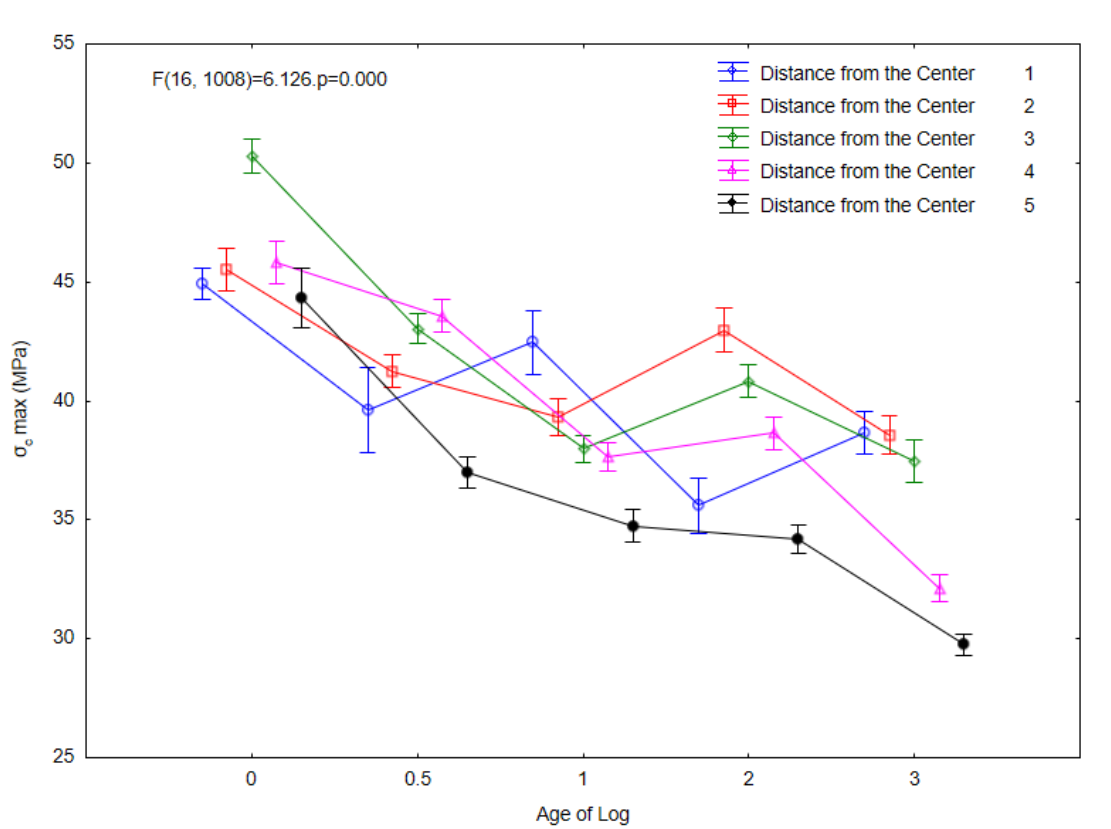
Figure 9. Statistical evaluation of the effect of age of log and distance from center on tensile strength using ANOVA .